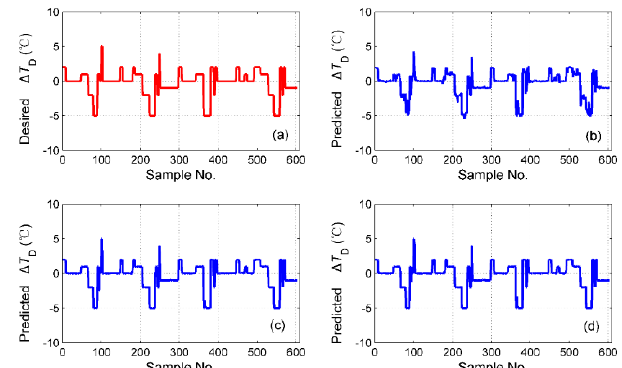
Figure 18. The simulation results of ∆𝑇 𝐷 for different fusion schemes, namely: ( a ) desired ∆𝑇 𝐷 ; ( b ) predicted ∆𝑇 𝐷 for feature level data fusion; ( c ) predicted ∆𝑇 𝐷 for decision level data fusion; ( d ) predicted ∆𝑇 𝐷 for hybrid multi-sensor data fusion.